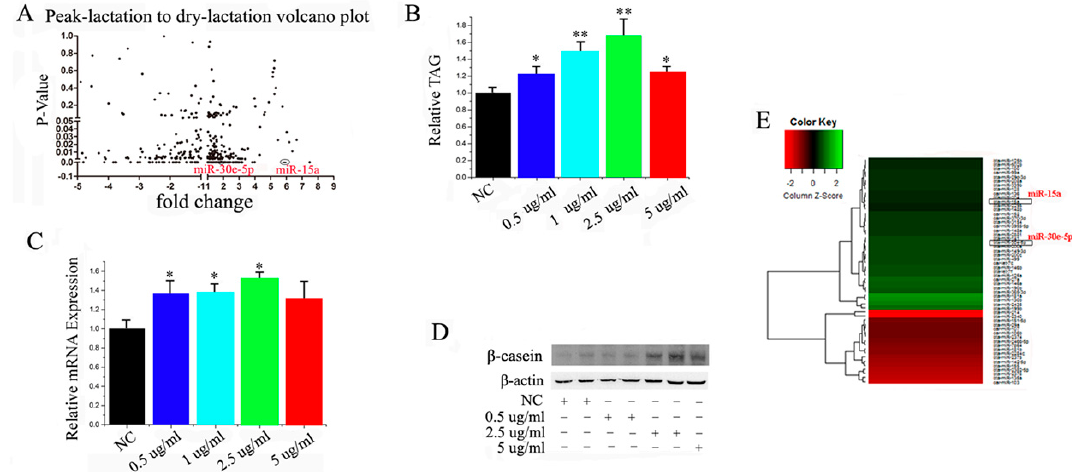
Figure 1. ( A ) Screening of microRNA (miRNA) expressed at peak-lactation and non-lactating stages. Three mammary samples from goats at each stage of lactation were used; ( B ) Triglyceride levels in cells treated with increasing concentrations of prolactin; triglyceride levels were compared with controls ( n = 6), * p < 0.05; ** p < 0.01; ( C ) Goat mammary epithelial cells (GMEC) were cultured with prolactin for 48 h, and the expression of β -casein was quantified by RT-qPCR ( n = 6), * p < 0.05. All experiments were duplicated and repeated three times. Values are presented as means ± standard errors; ( D ) Western blot analyses of the expression of β -casein in the prolactin treatment experiments. The effect of prolactin on β -casein protein expression was evaluated by Western blot in GMEC; ( E ) Screening for miRNAs involves in the 0 µ g/mL prolactin and 2.5 µ g/mL prolactin, respectively. The expression of 18s rRNA is used as a normalization control.